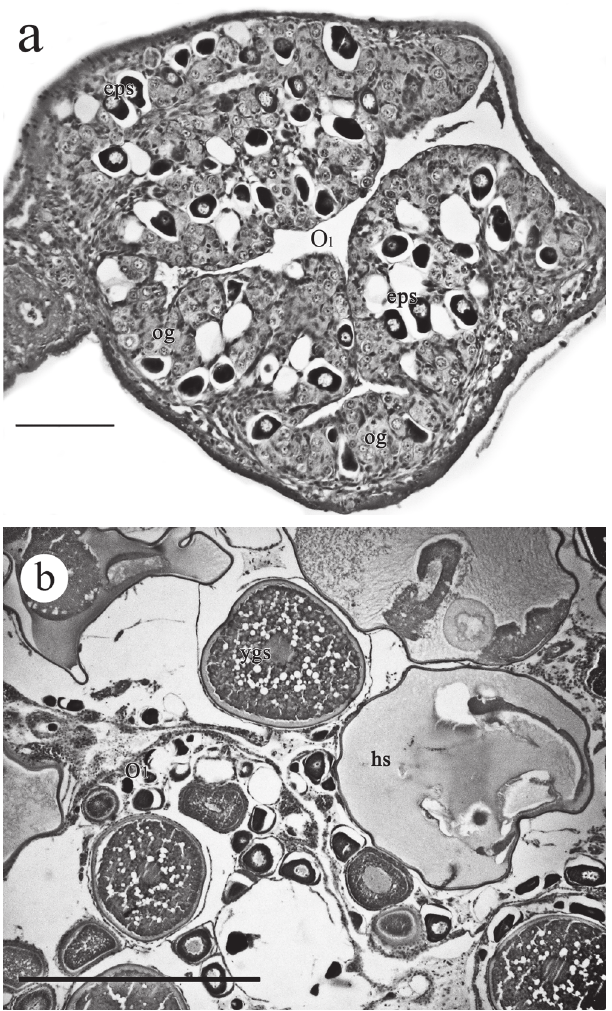
Fig. 1. Photomicrographs of histological sections from females Alphestes afer gonads. (a) Section from a immature female (bar = 100 μ m) (11.6 cm T ; February 2010). (b) Section from a L ripe female (bar = 500 μ m) (19.6 cm T ; October 2009). og = L oogonium, eps = early perinucleolus stage, ygs = yolk vesicle stage, hs = hydrated stage, O = primary growth stage 1